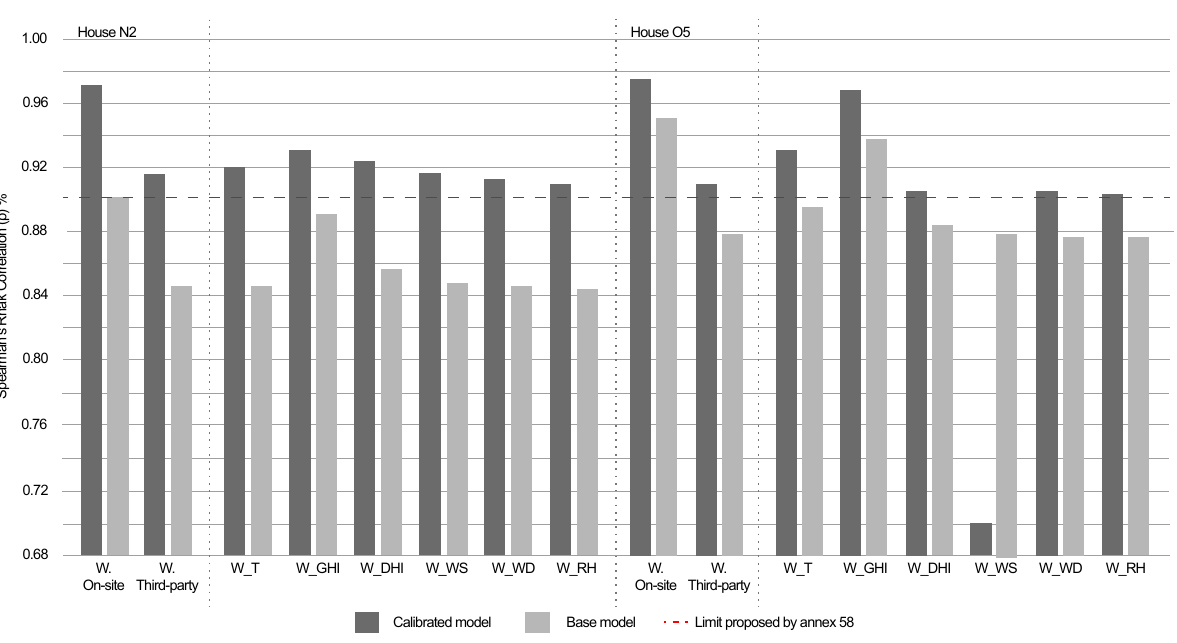
Figure 10. Results of the ρ index of the base and calibrated models with the different weather files created. Checking period, Houses N2 and